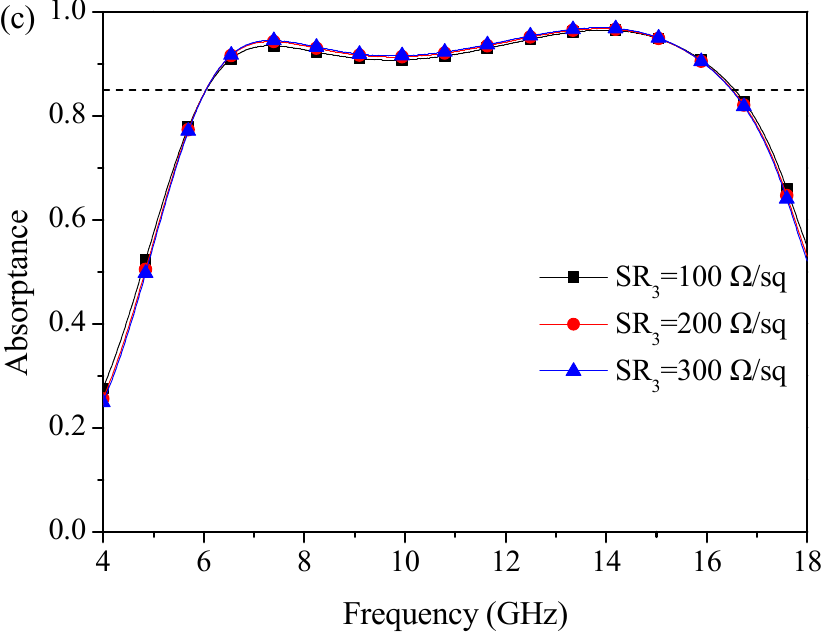
Figure 4. Absorption performance of the absorber for different sheet resistances of the ITO layers: ( a ) varied SR 1 ; ( b ) varied SR 2 ; ( c ) varied SR 3 .